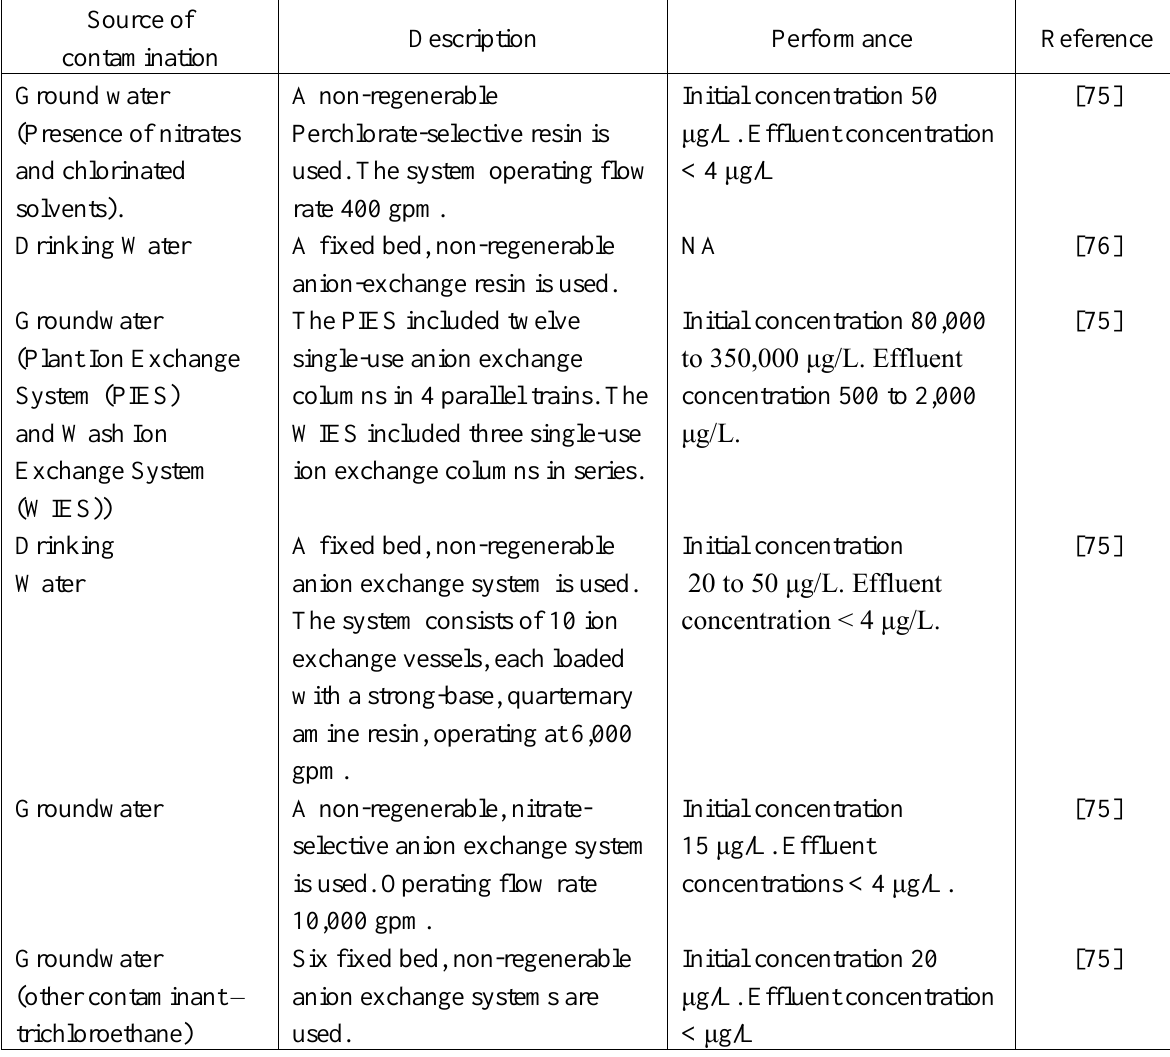
Table 5. A summary of performance of ion exchange used for treatment of